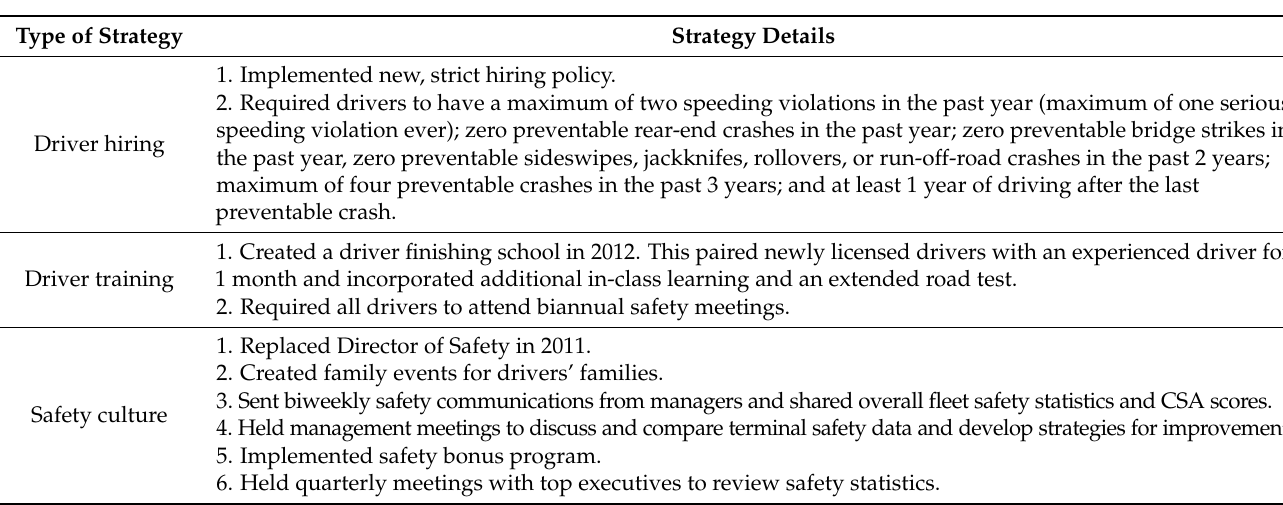
Table 5. Fleet C’s safety improvement